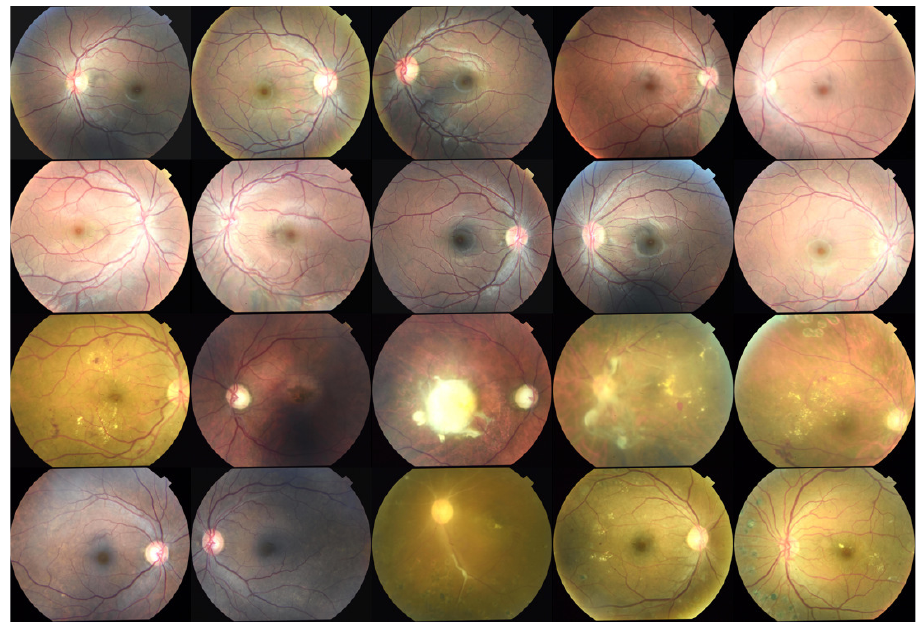
Figure 1. Complete image dataset. Healthy patients (rows 1 and 2). Non-healthy patients (rows 3 and